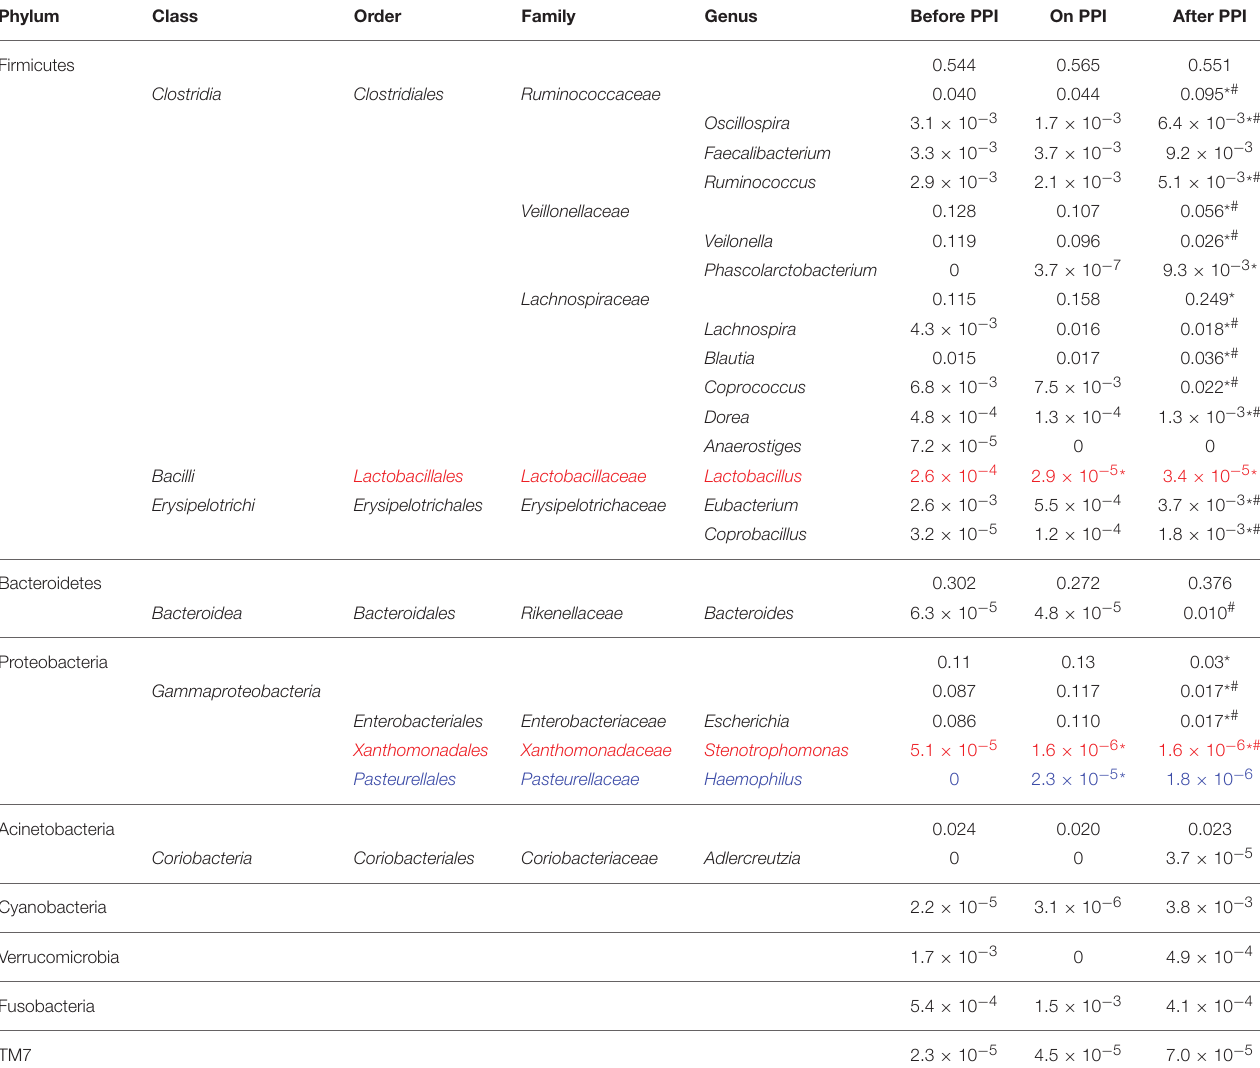
TABLE 3 | Mean relative abundances (RA) at the different levels.